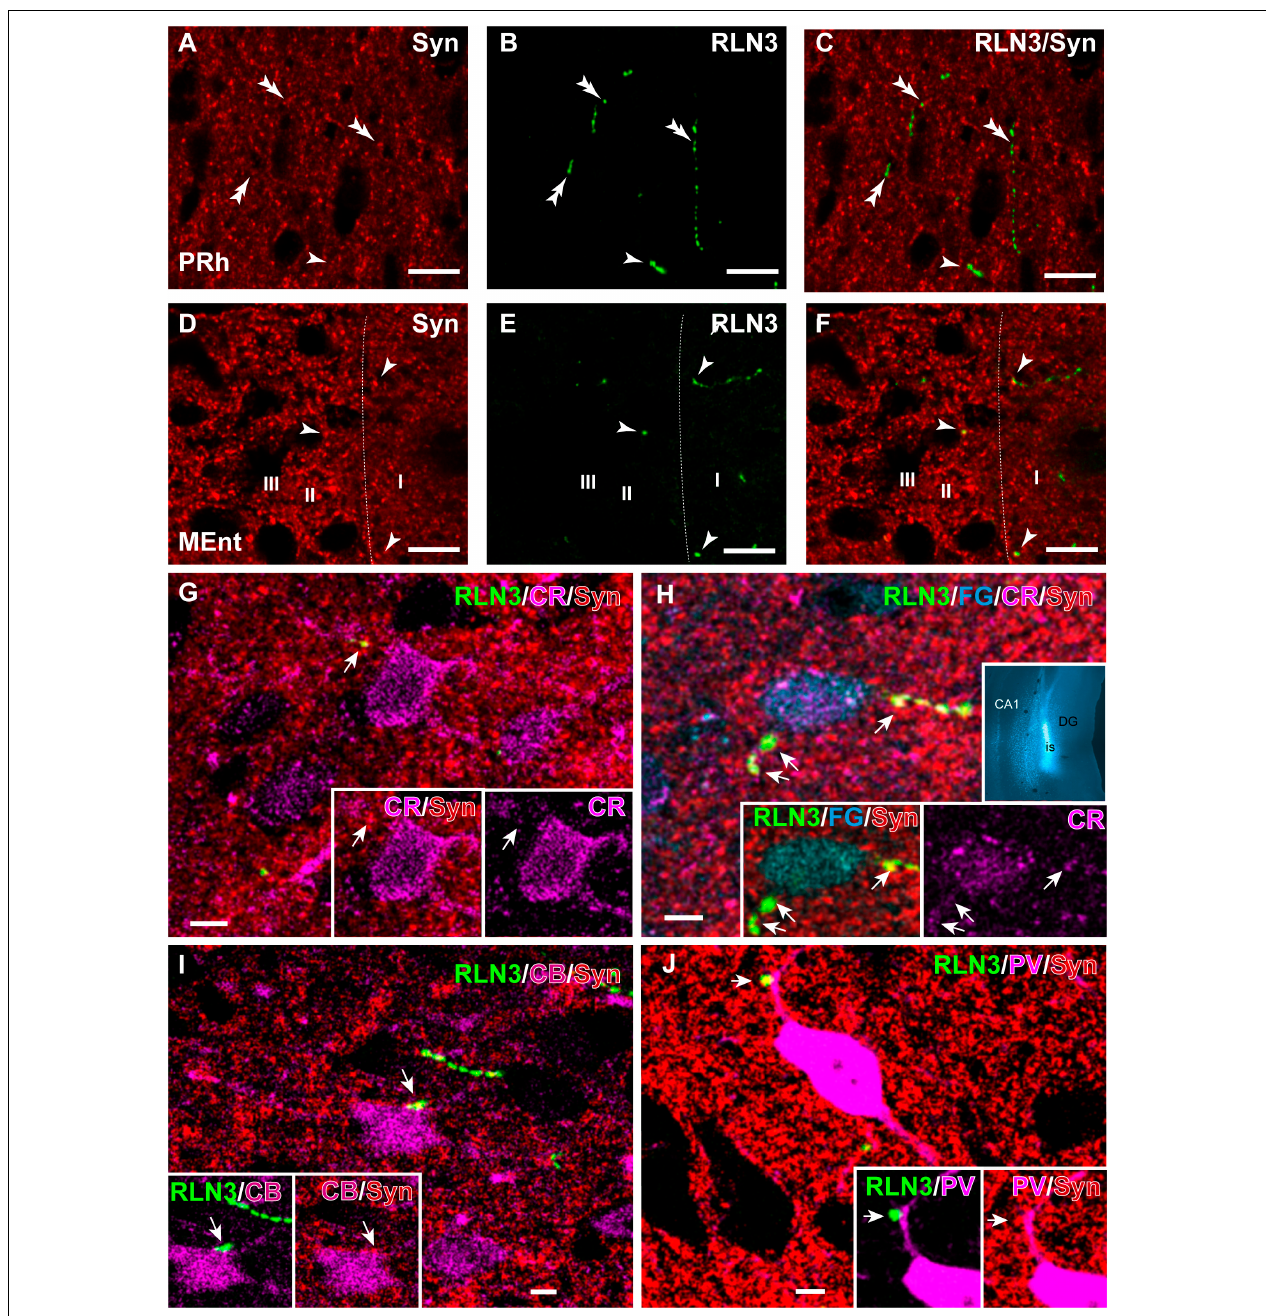
FIGURE 11 | Presence of synaptophysin in RLN3 fibers innervating the parahippocampal cortex. (A–F) Confocal images illustrating the presence of synaptophysin (Syn, red) in RLN3 fibers (green). (A–C) Sequence of 0.5 µ m sections captured with the 40 × objective for (A) Syn, (B) RLN3, and (C) merge in the deep layers of the PRh. Calibration bar 5 µ m. Colocalization of fibers and putative terminals are indicated by arrowheads and non-overlapping Syn and RLN3 staining is indicated by double arrowheads. (D–F) Sequence of 0.5 µ m sections captured with the 40 × objective for (A) Syn, (B) RLN3, and (C) merged image in the MEnt. Most fibers in this area displayed an overlap of RLN3 and Syn. (G–J) Putative close appositions between RLN3 fibers and either CBP-positive (magenta) or FG-positive (cyan) neurons projecting to the dentate gyrus (inset in H ) of case Sec 6. Syn was observed in the contact. Calibration bars (G–J) , 5 µ m. (G) Confocal single 0.5 µ m section of a CR-positive neuron in the MEnt receiving a close apposition from a RLN3 fiber displaying colocalization with Syn puncta. Notably, the Syn and RLN3 puncta also displayed CR IF (arrow). (H) Quadruple-labeling for CR, RLN3, FG, and Syn in the superficial layers of the MEnt illustrating a retrograde-labeled (FG injected into the DG, cyan, inset) neuron that is also CR-positive (cyan) and receives RLN3 puncta (green), which are positive for Syn (red). Arrowheads point at puncta that are positive for RLN3, Syn and CR. (I) CB-positive neuron receiving close apposition puncta over the soma that is positive for RLN3 and Syn. (J) A overlay of 6 µ m illustrating a PV-positive neuron in the LEnt receiving a close apposition puncta on a primary dendrite which is positive for both RLN3 and Syn, as shown in the single 0.5 µ m images (insets).